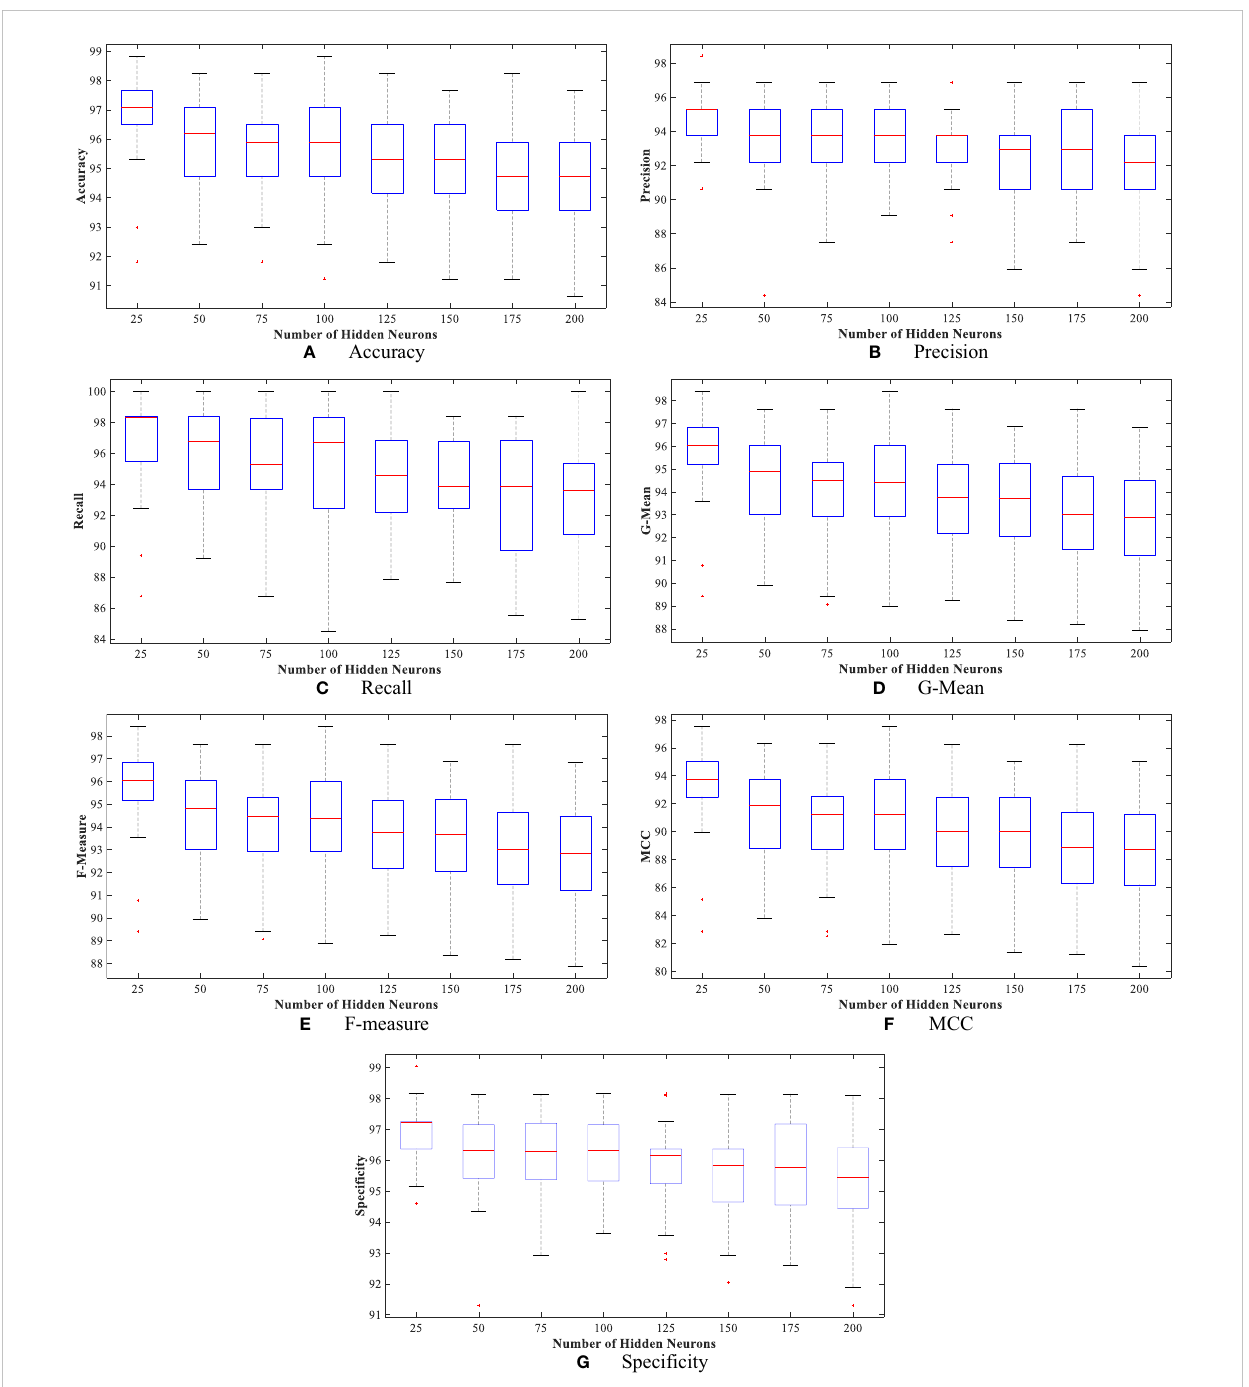
FIGURE 5 The proposed FLN algorithm ’ s results for the 50 runs in all experiments using the WBCD. (A) FLN algorithm accuracy results for the 50 runs in all experiments, (B) FLN algorithm precision results for the 50 runs in all experiments, (C) FLN algorithm recall results for the 50 runs in all experiments, (D) FLN algorithm G-mean results for the 50 runs in all experiments, (E) FLN algorithm F-measure results for the 50 runs in all experiments, (F) FLN algorithm MCC results for the 50 runs in all experiments, and (G) FLN algorithm speci fi city results for the 50 runs in all